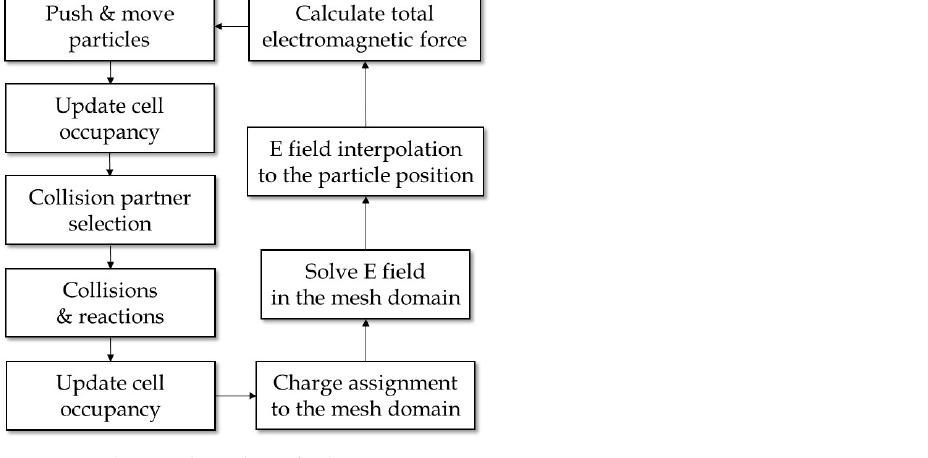
Figure 1. Solution algorithm of pdFOAM. Table 1. Model capabilities of pdFOAM [14].